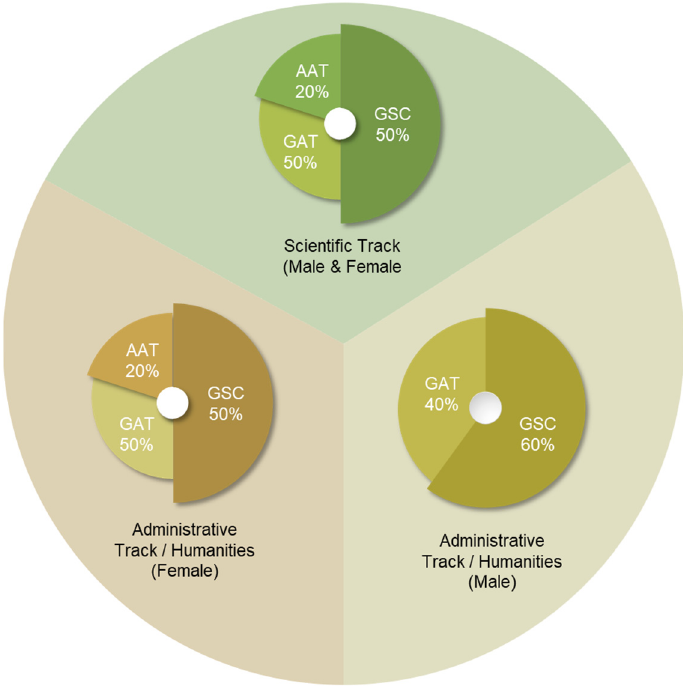
Figure 1. How to calculate the weighted ratio of admission AWR to the tracks for male and female students ( KAU Preparatory Year 2021 ).